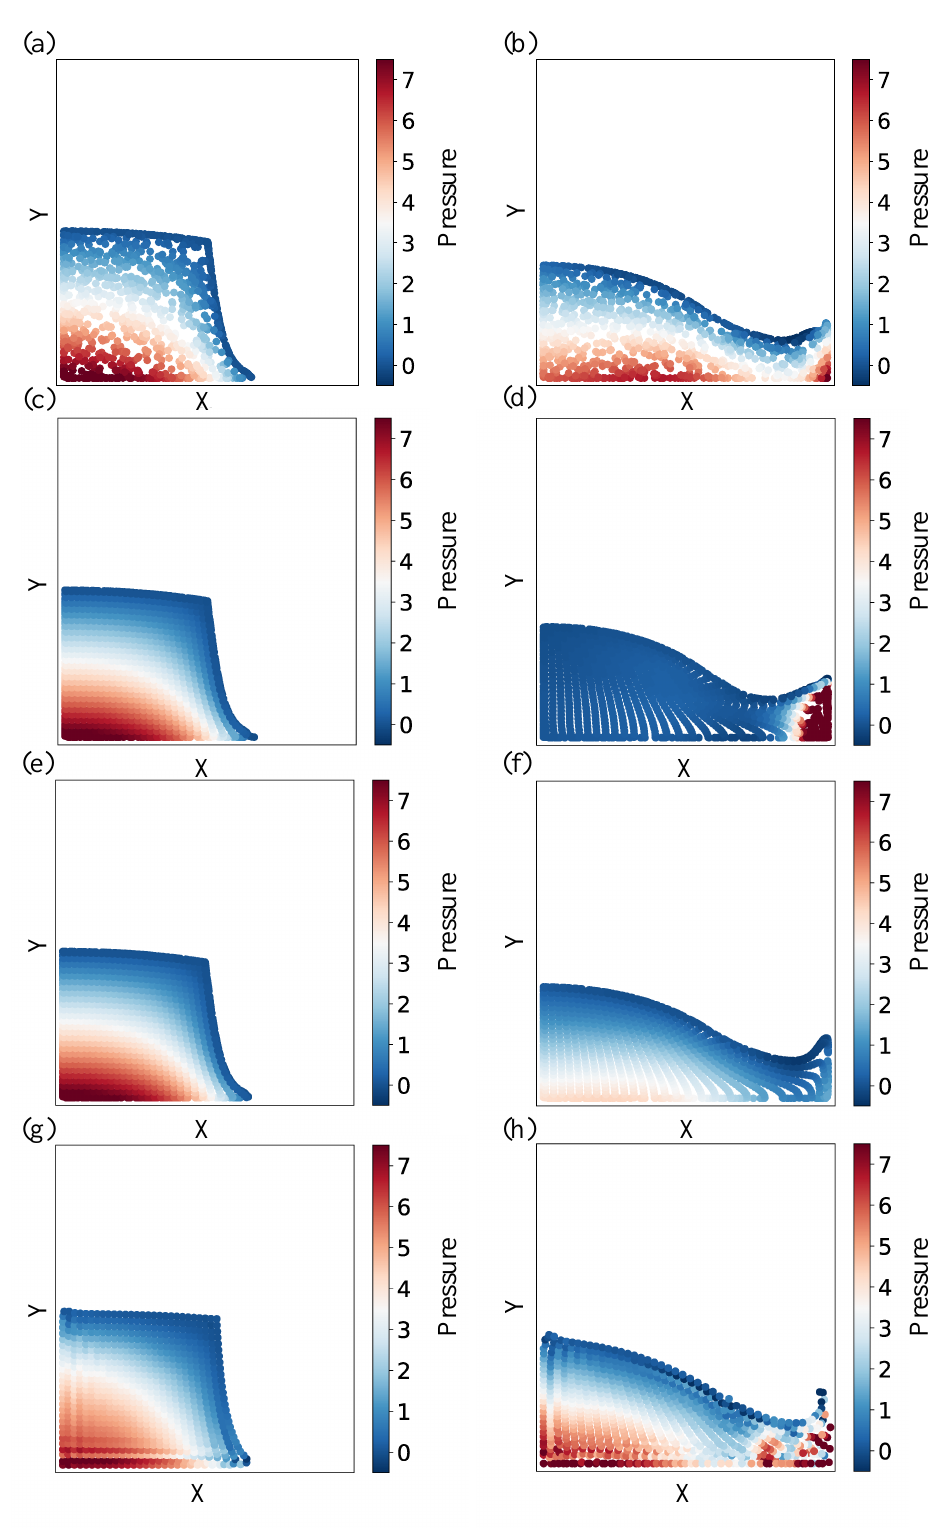
Figure 6. Configurations and the pressure contours of the fluid at t = 0.16, 0.56 s. ( a , b ) INPM with randomly distributed particles; ( c , d ) INPM with uniformly distributed particles; ( e , f ) NPM with uniformly distributed particles; ( g , h ) SPH with uniformly distributed